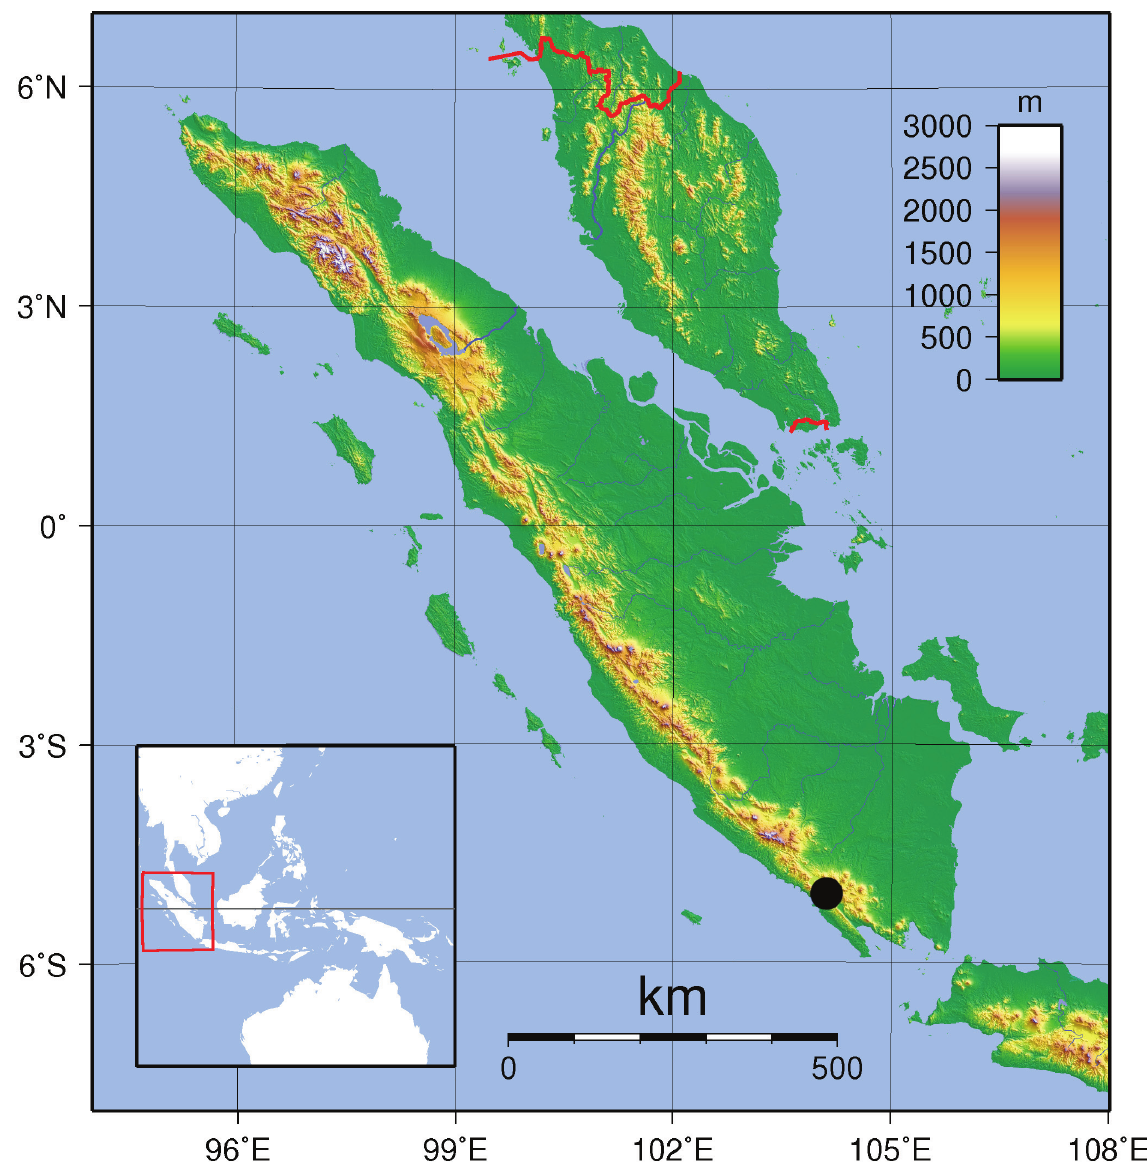
Fig. 26. Egregia laprincesse sp. nov., distribution